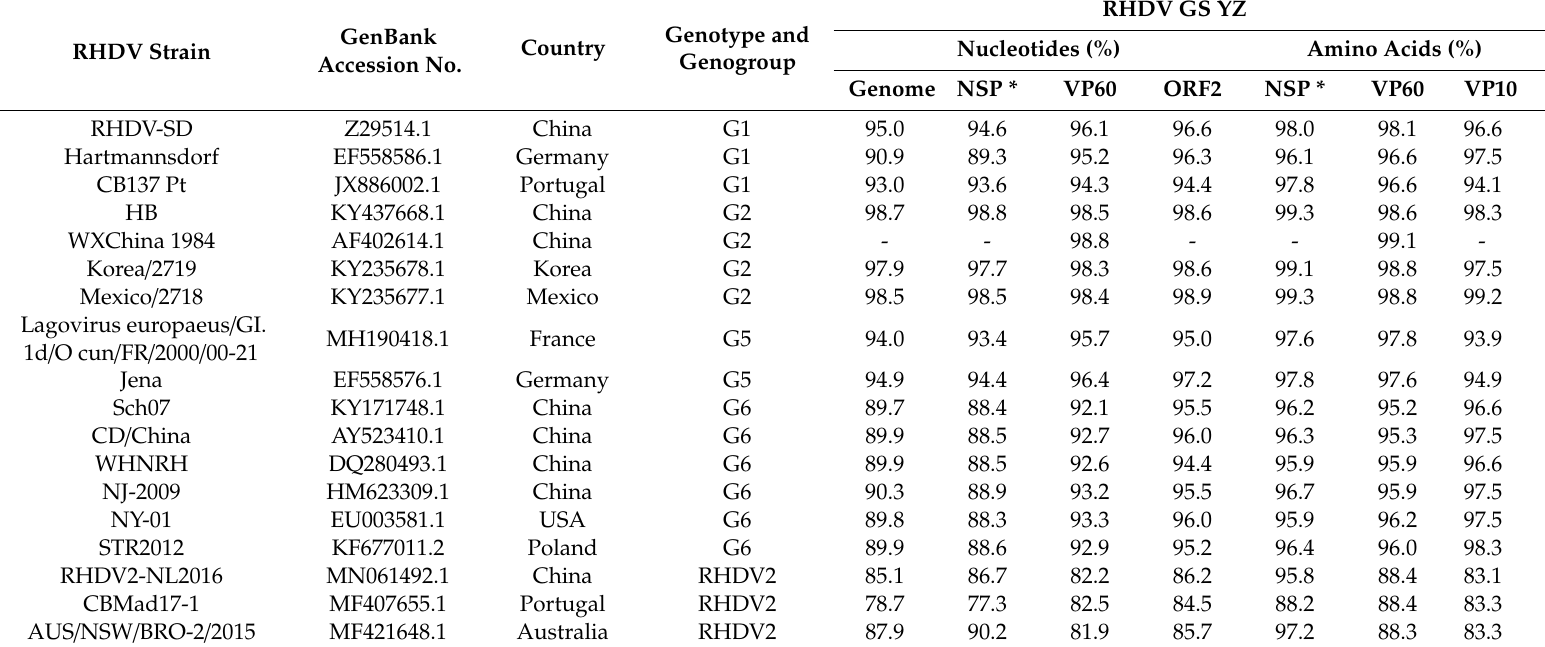
Table 2. Identities of nucleotide and deduced amino acid sequences of RHDV GS / YZ with 18 selected reference RHDV